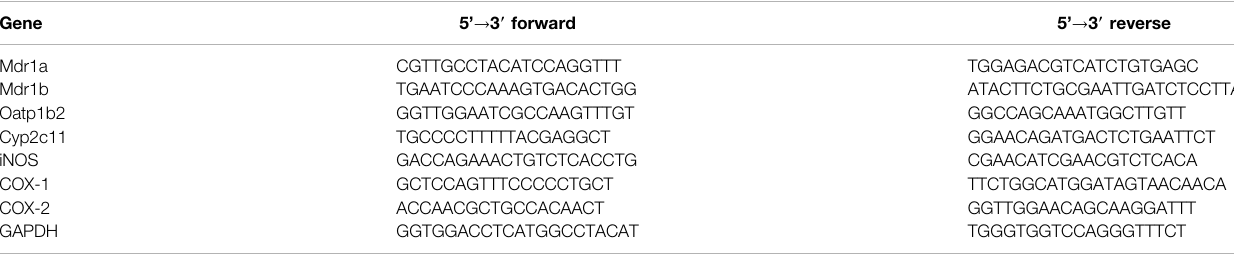
TABLE 1 | Primer sequences for quantitative real-time